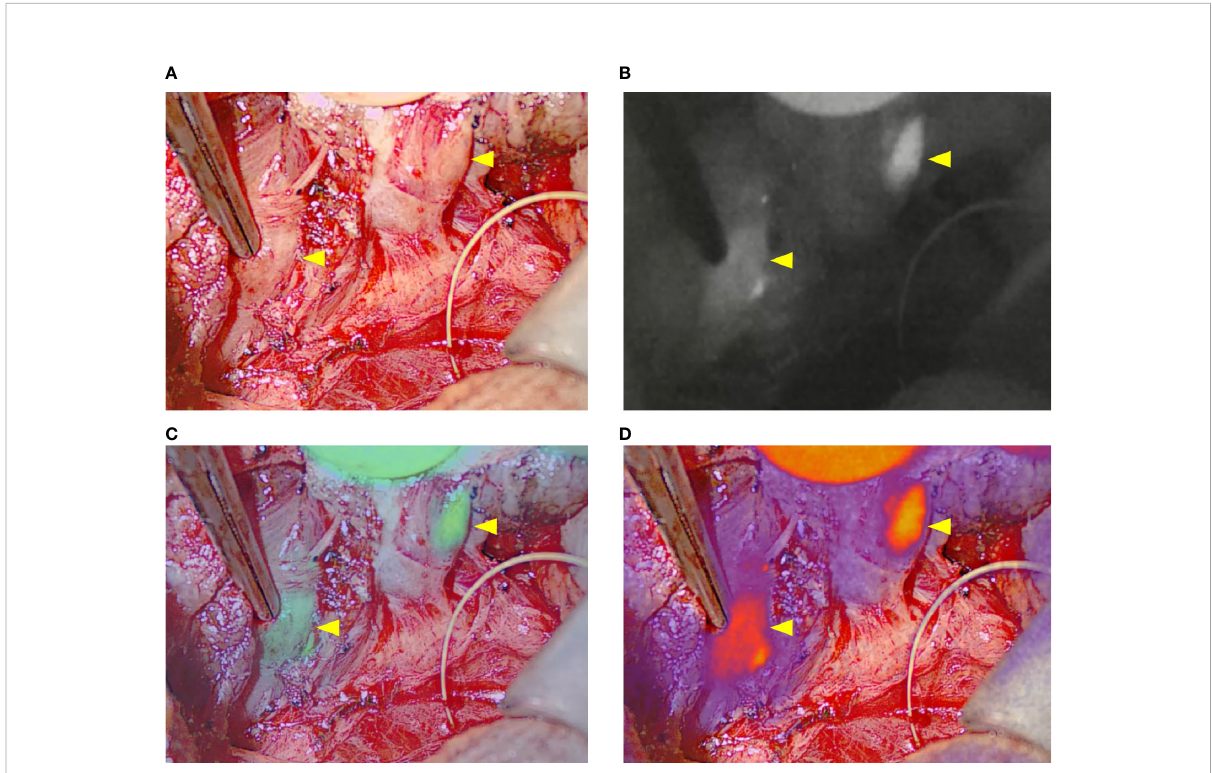
FIGURE 1 The four visualization modes of the EleVision IR system. (A) white light image; (B) black and white near infrared fl uorescence image; (C, D) overlay of white light image and fl uorescence image with a monochrome (C) or divergent (D) color map applied; yellow arrows indicate parathyroid